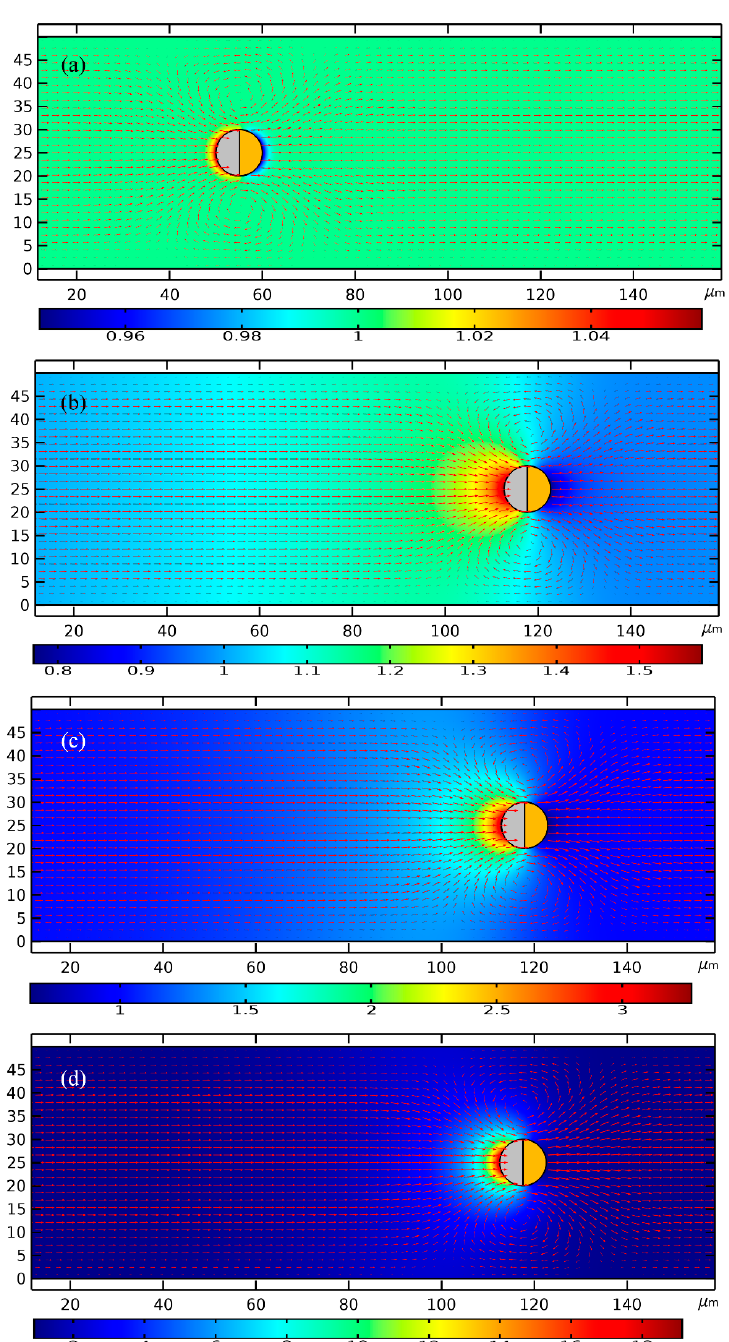
Figure 6. A simulation investigation of the application of the e-DEP-enabled unidirectional delivery of the Janus ME (PP) in simultaneous hydrodynamic loading and collection of the nanoscale biomolecules (SP) from the surrounding liquid suspension in the high-frequency limit. ( a – d ) An arrow plot of the hydrodynamic flow field due to the e-DEP motion of the Janus ME, and a surface plot of the concentration field of the biomolecules (unit: nM) inside the fluidic chamber at f = 10 MHz, ( a ) at t = 0 s, ( b ) at t = 2.7 s for V AC = 1 V, ( c ) at t = 1.2 s for V AC = 1.5 V, and ( d ) at t = 0.67 s for V AC = 2 V (See Supporting Video S4). In ( b – d ), the Janus PP has moved a same horizontal distance of 60 µ m as compared to ( a ). Besides, with increasing voltage from ( b ) to ( d ), the concentrating factor of the SP increases, while the collection area reduces.